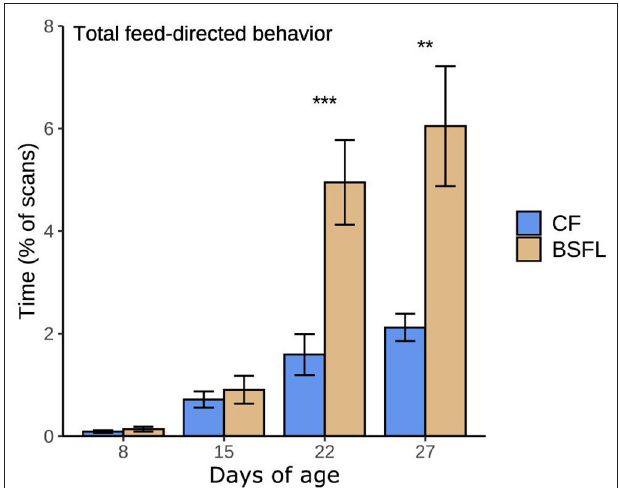
FIGURE 4 | Time spent on all feed-directed behaviors (exploring feeder, exploring or playing with feed, and eating feed) toward creep feed (CF) and black soldier fly larvae (BSFL) as observed in the home pen of Pre-L piglets. Per day, effects of feed type are indicated as **( p < 0.01) or ***( p < 0.001). Data are presented as pen means ± SEM.